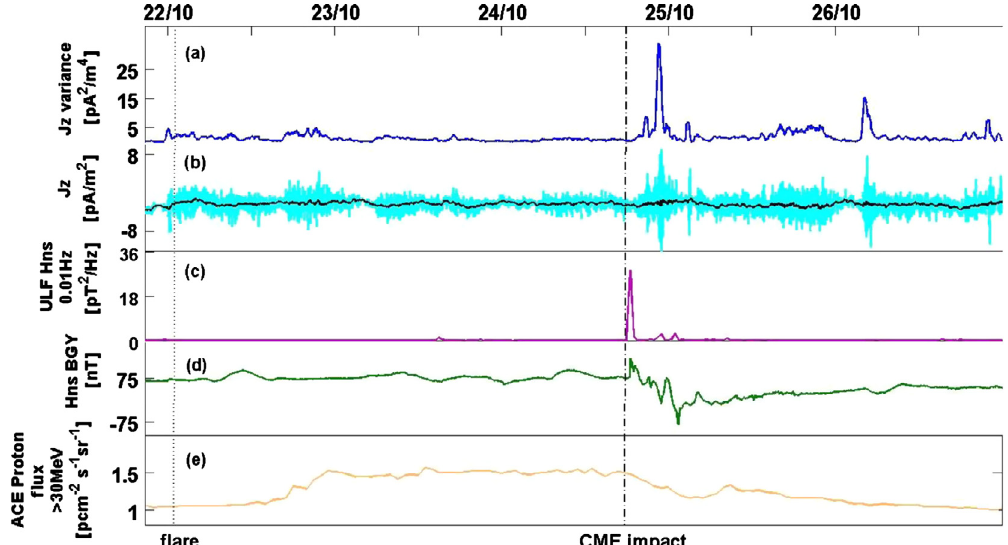
Figure 3. (a) J z fluctuations measured in MR during 22–27 of October 2011. (b) Average J z (turquoise) and the 30 min averaged J z (black). (c) Magnetic ULF spectrum at 0.01 Hz measured in MR. (d) Magnetic field NS DC component, Bar Giora, Israel. (e) ACE 30 MeV Proton Flux. Dotted vertical line marks the flare onset. Dashed vertical line marks the CME impact with the atmosphere.